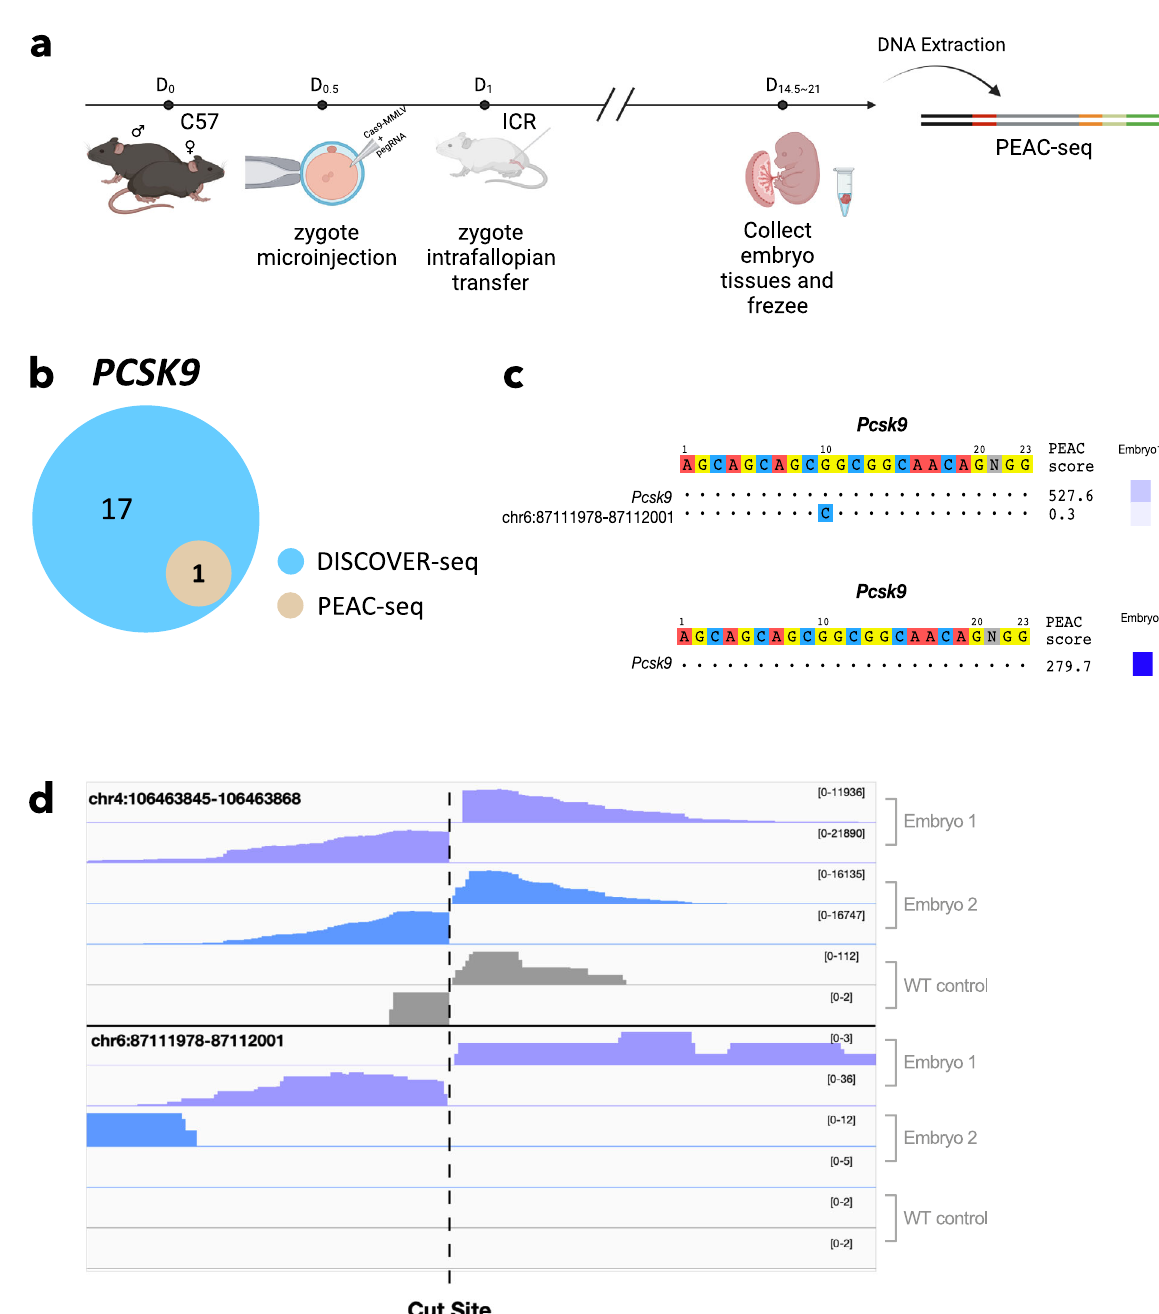
DISCOVER-seq and validated by Amplicon-seq. The color scale represented the indelfrequencyreportedbyCRISPResso. d Thesignaltrackoftheon-targetandoff- target sites identi fi ed from PEAC-seq in two different embryos and wild-type con- trol.The signal of the WT control at chr4:106463845 was 1000-fold lower thanthe sample and was considered as background. Source data are provided as a Source data fi